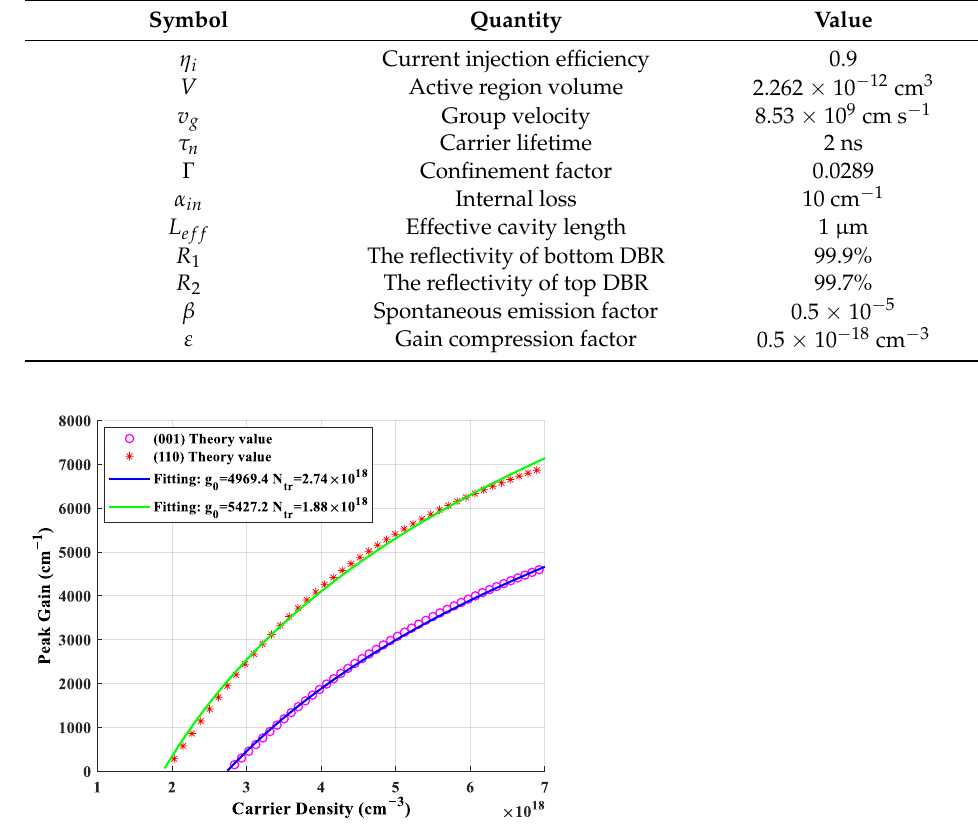
Figure 9. Gain versus carrier density curve fits for (001) and (110) crystal orientations in strain InGaAs QW. Table 2. Parameters used in the simulation of VCSEL. Adapted with permission from [5].